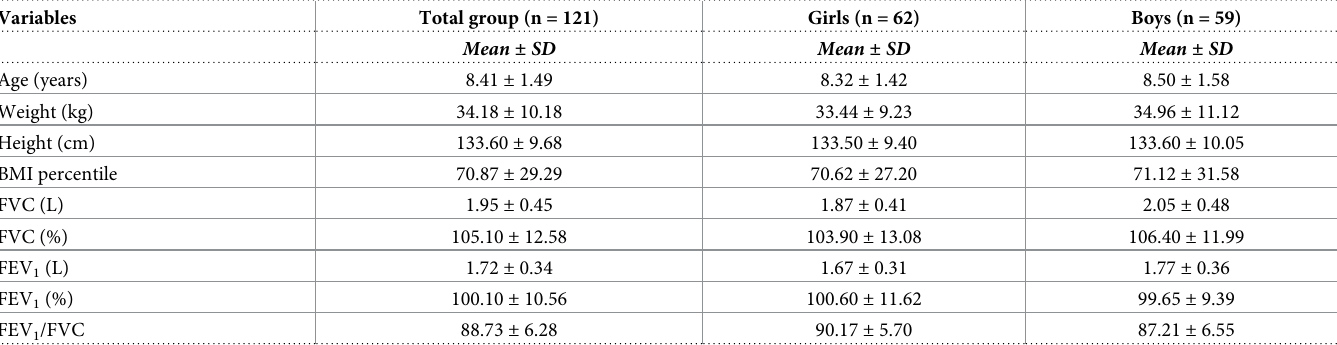
Table 1. Anthropometric characteristics and pulmonary function stratified by sex.